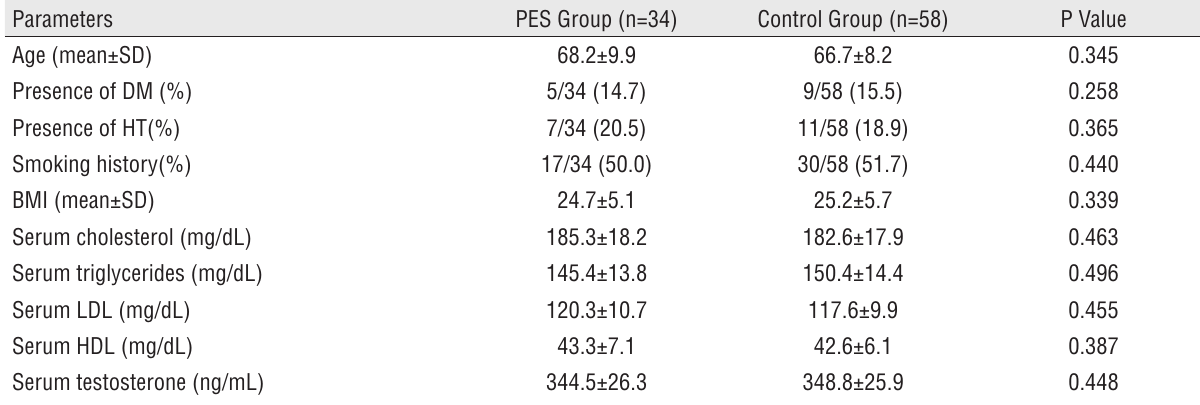
Table 1 - Demographic characteristics and serum measurements of the patients.